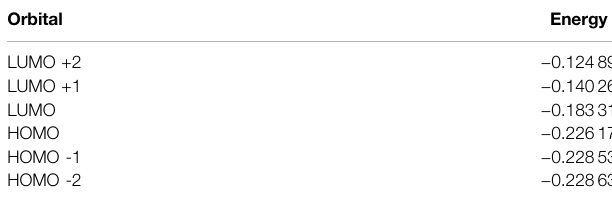
TABLE 4 | Energies (in Hartree) of molecular orbitals in the [Rh 2 (O 2 CCF 3 ) 4 ] at the M06 – L/def2 – QZVPPD level of theory.